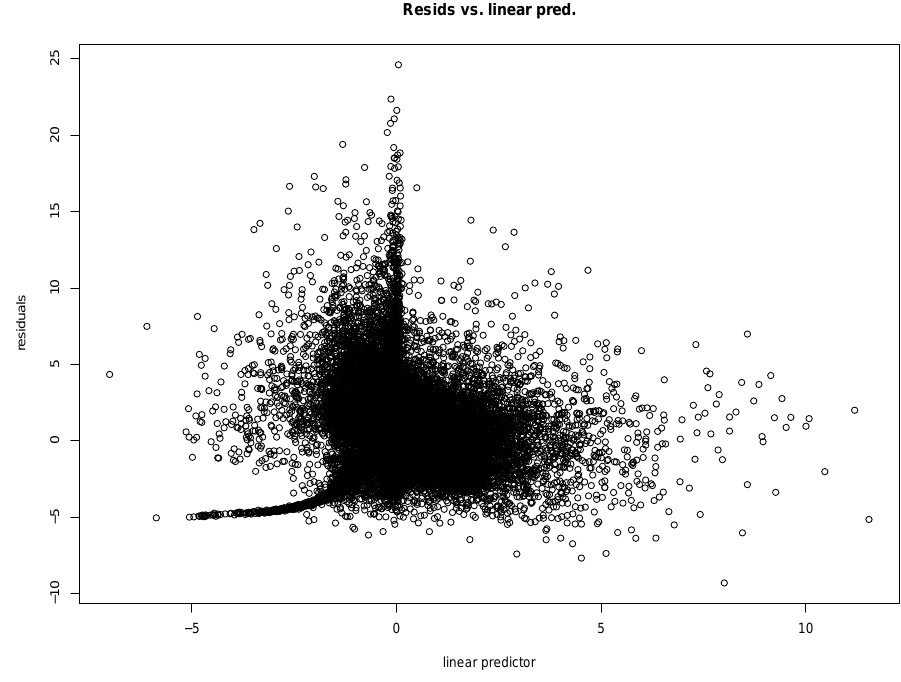
Figure A7. GAM Model Diagnostics (2).